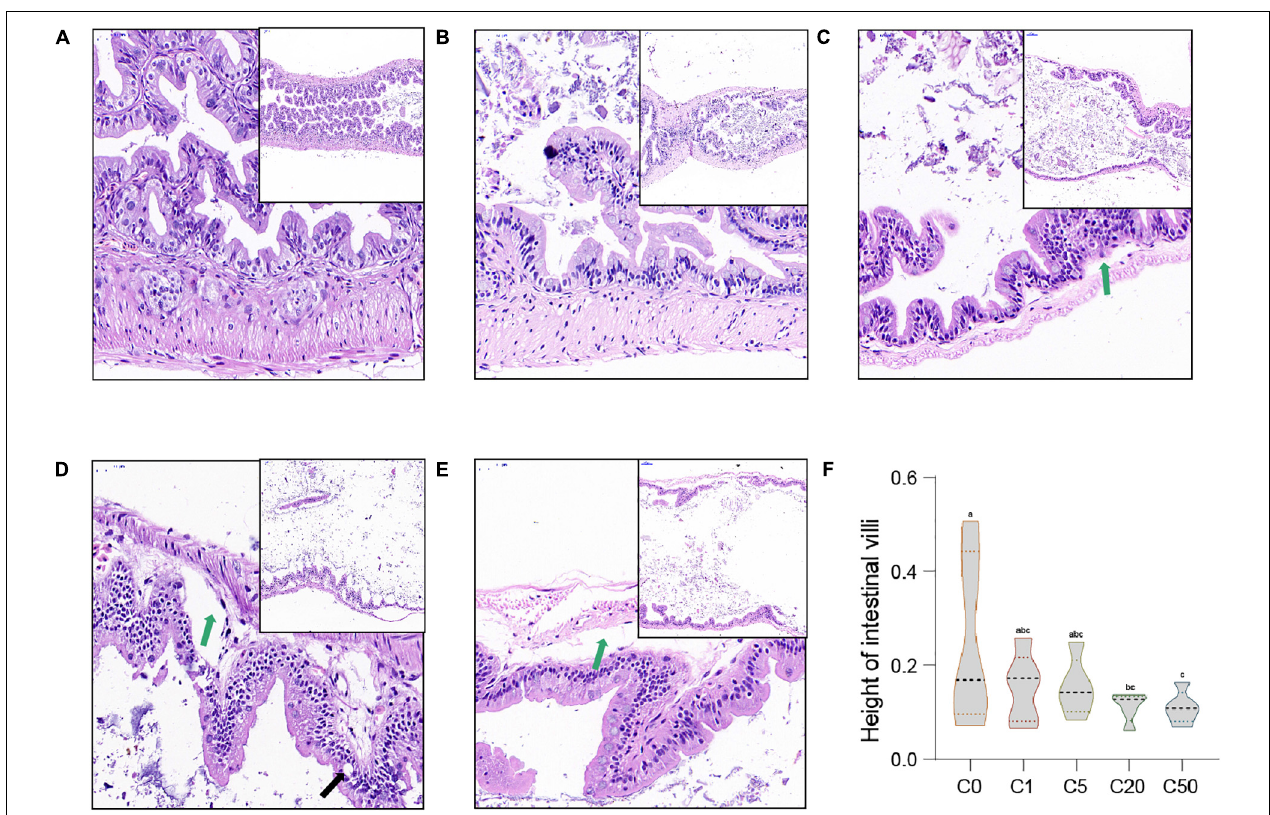
FIGURE 3 | Intestinal microstructural changes of Xenopus laevis exposed to different concentrations of MC-LR. (A–E) Indicate the intestinal micrographs of Xenopus laevis exposed to 0, 1, 5, 20, and 50 µ g/L MC-LR, respectively. (F) Intestinal villus height. Green and black arrows indicate the gap between the base and villi and vesicular vacuolization, respectively. Numbers after the letter C in the group names indicate MC-LR concentrations. Different letters above boxes indicate significant differences between the groups ( P < 0.05).